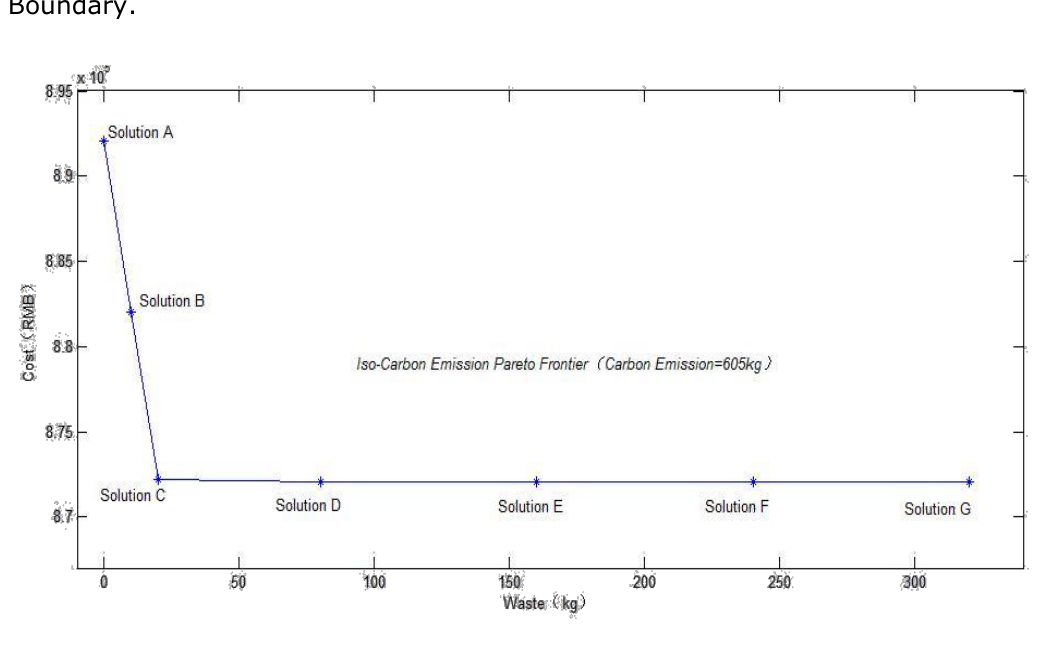
Figure 6. The Iso- CO 2 Emission Pareto Boundary